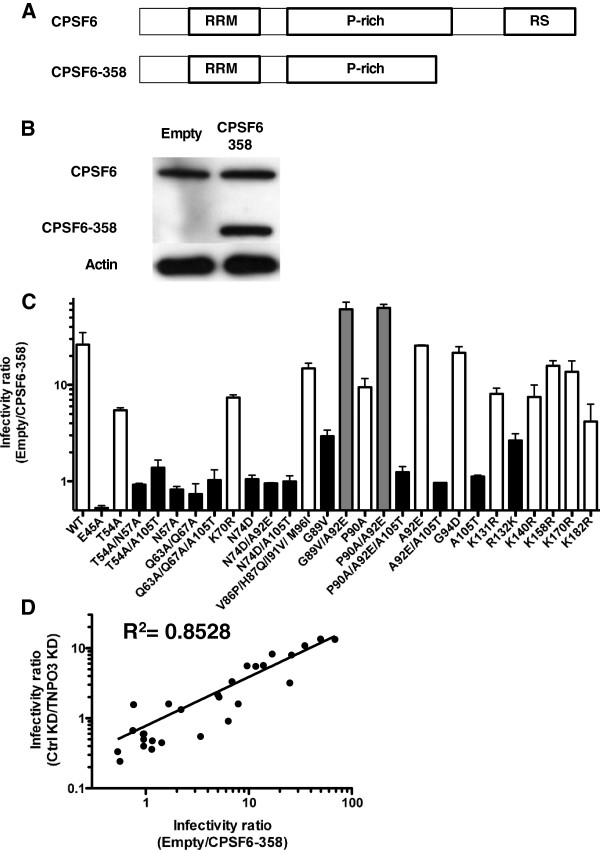
The effect of CPSF6-358 on the infectivity of HIV-1 CA mutants correlates with the effect of TNPO3 KD. (A) Schematic representation of the protein domains of WT CPSF6 and the truncated mutant CPSF6-358. RNA recognition motif (RRM), proline-rich domain (P-rich), arginine/serine rich domain (RS). (B) Expression levels of CPSF6 in TZM-bl cells transduced with empty or CPSF6-358 vectors. Cell lysates were probed in western blots with anti-CPSF6 antibody (upper panel) and anti-β-actin antibody (lower panel). The upper panel shows the endogenous CPSF6 and the truncated form. (C) TZM-bl cells transduced with an empty vector or with a vector encoding CPSF6-358 were challenged with a panel of 27 HIV-1-GFP reporter vectors bearing either WT CA or the indicated CA mutants. At 72 hrs the percent GFP+ cells was determined by flow cytometry as an indication of infectivity. The ratio of HIV-1 infectivity in CPSF6-358 expressing cells and empty vector cells is shown. White bars show CA mutants inhibited to a similar extent as the WT virus by CPSF6-358, black bars shows CA mutants insensitive or slightly sensitive to CPSF6-358, and gray bars show CA mutants hypersensitive to the presence of CPSF6-358 in the cell. (D) Correlation between the infectivity ratios of the 27 CA mutants when infecting Ctrl KD vs TNPO3 KD [8] and Empty vector vs CPSF6-358 (R2 = 0.8528).